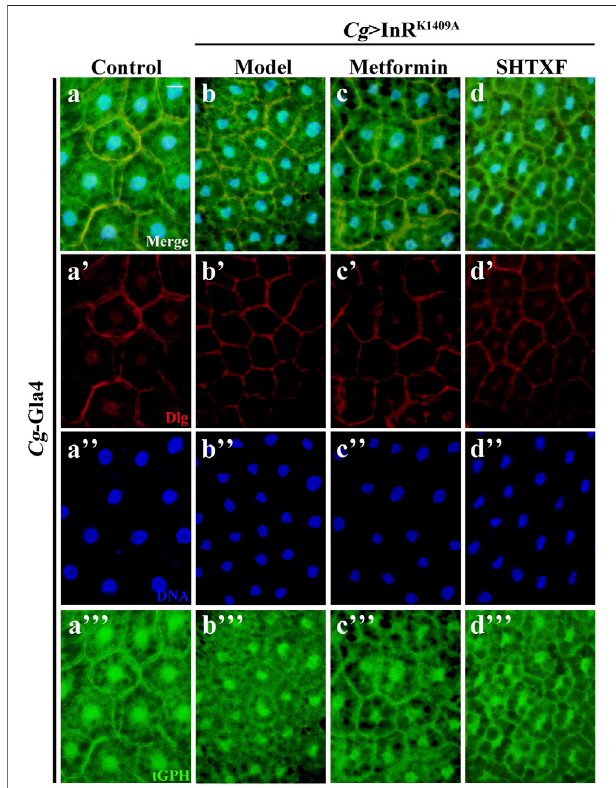
FIGURE5| SHTXFimprovesthePI3Kactivity invivo .Therepresentative merged fl uorescence micrographs show the third-instar larval fat body carrying the tGPH reporter stained with anti-Dlg, which outlines the cell membranes.TheindividualchannelsdetectonlyDlgsignal[red, (A ’– D ’ ) ], and only tGPH [green, (A ’’’– D ’’’ ) ]. Nuclei were labeled with DAPI [blue, (A ’– D ’ ) ]. Scale bar, 20 μ m. Genotypes: (A) Cg -Gal4/+; tGPH/+ and (B –